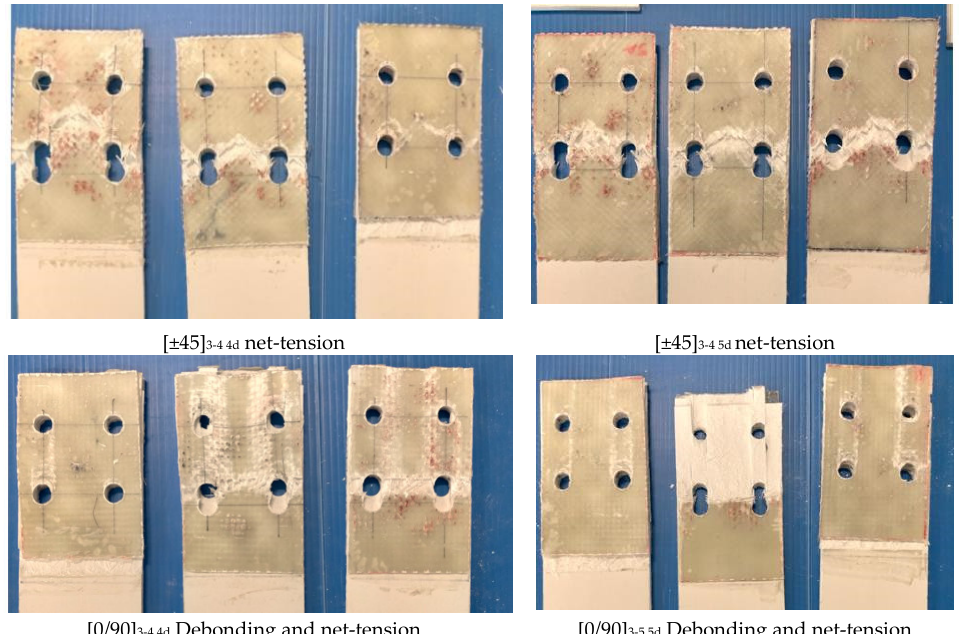
Figure 9. Typical failure modes of the PGFRP connections in the expanded GFS specimens.